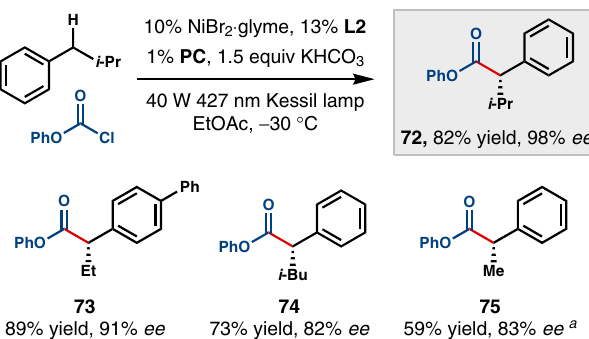
Fig. 6 Rational expansion for the synthesis of α -aryl esters. All data represent the average of two experiments. Unless otherwise noted, reactions were conducted on a 0.5 mmol scale under stated conditions. a In place of the stated conditions, the reaction was conducted at − 40°C with 5.0 equiv ethylbenzene.